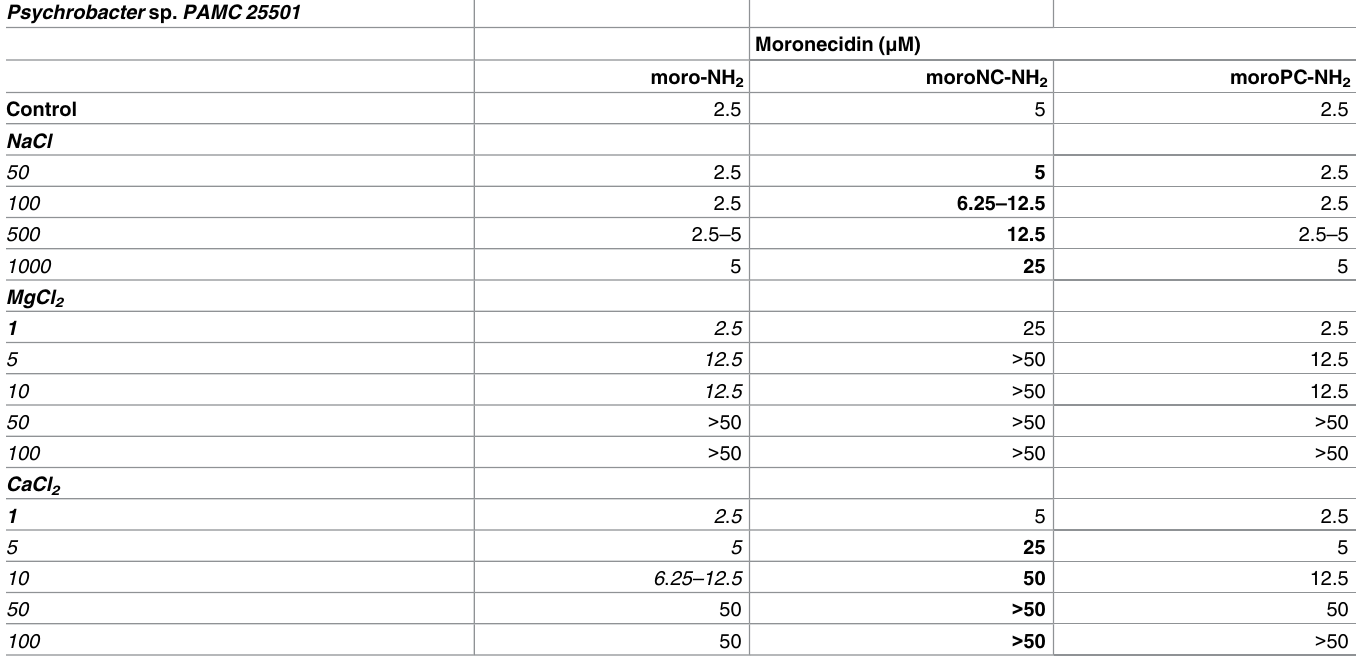
Table 7. Effects of monovalent and divalent cations on AMP activity against Psychrobacter sp. PAMC 25501 . Psychrobacter sp. PAMC